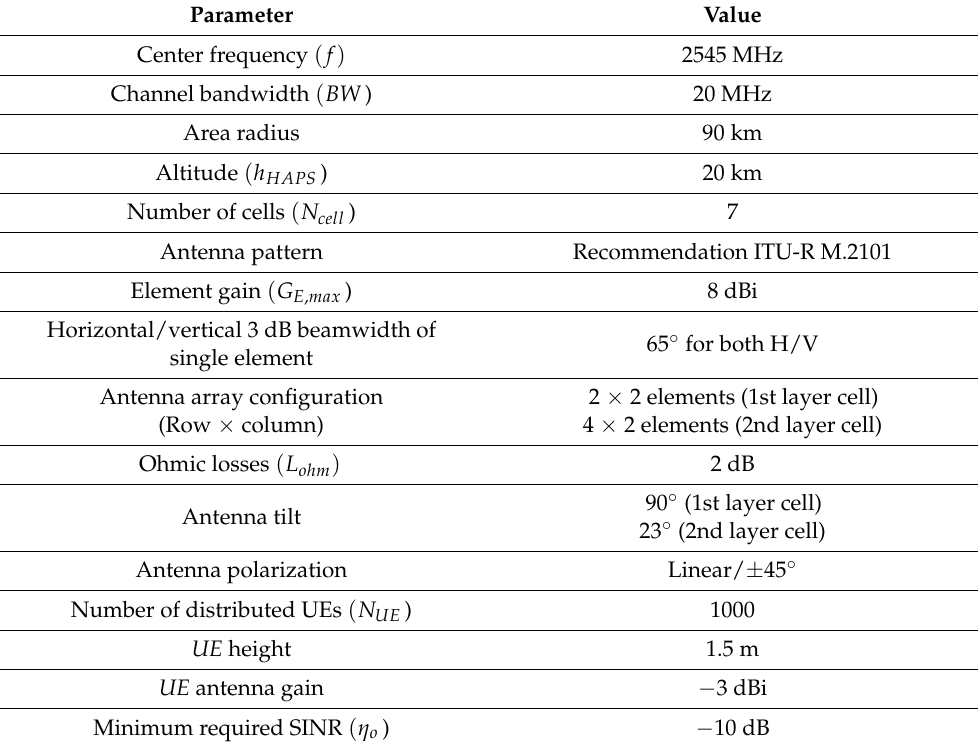
Table 1. HAPS system parameters.